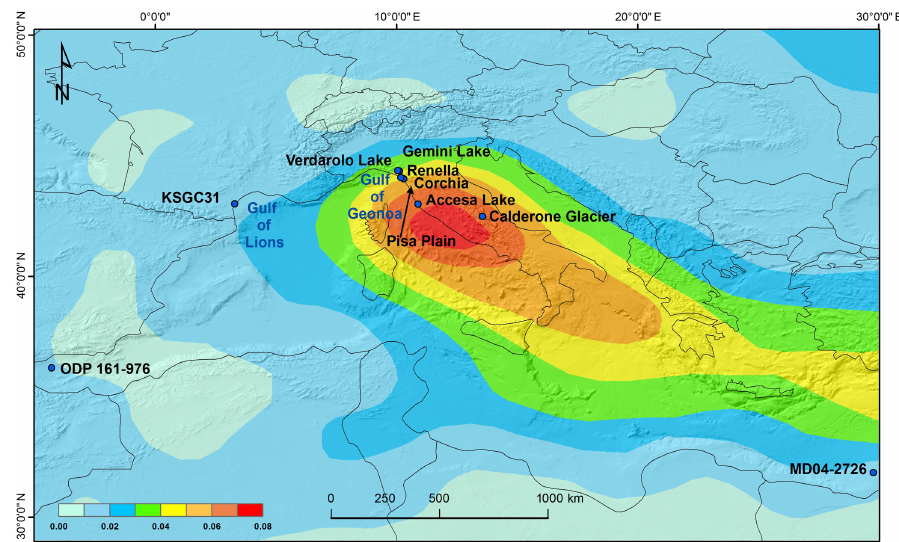
Figure 1. Location map of the sites discussed in the text. The figure shows the density track of winter storms according to ERA-Interim 1989–2009. Numerical values (number of cyclones/deg 2 ) represent the average spatial density of cyclone centers in the winter season. Only cyclones with a minimum of 1-day duration and 5hPa of depth with respect to the background are included (modified after Lionello et al.,